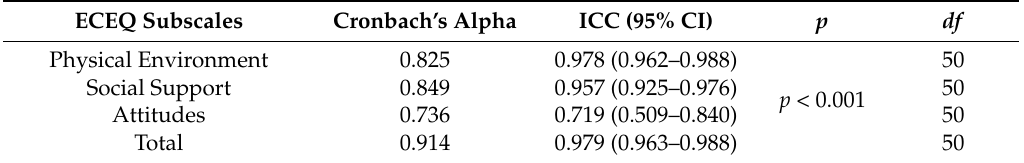
Table 2. Cronbach’s alpha ( N = 332) and internal consistency ( n = 51) of the ECEQ subscales, and total. ECEQ